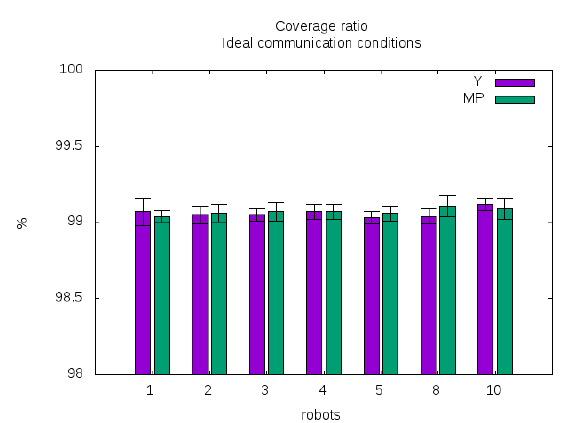
Figure 12. Coverage ratio (CR) under ideal communication conditions. Both approaches achieve a coverage bigger than 99% of the terrain regardless of the fleet